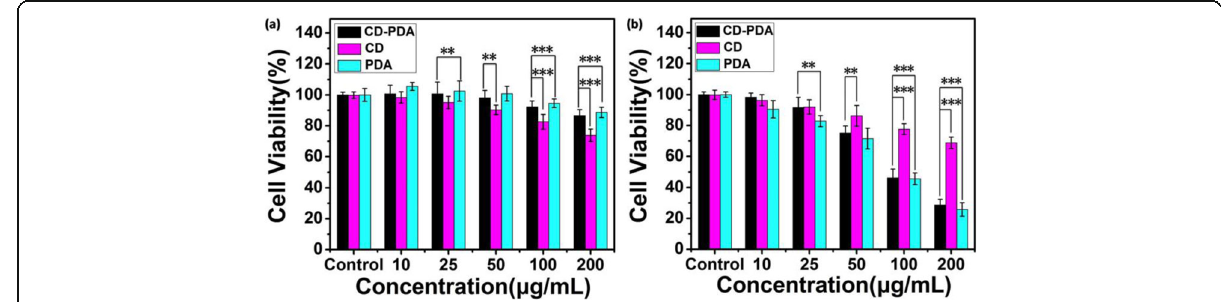
Fig. 5 In vitro cytotoxicity against HeLa cells. a In vitro cell viability of HeLa cells incubated with CD-PDA, CDs, and PDA at various concentrations for 24 h. b In vitro cell viability of HeLa cells incubated with CD-PDA, CDs, and PDA at various concentrations under irradiation (808 nm, 2 W/cm 2 , 5 min; mean ± SD, n = 6). * p < 0.05, ** p < 0.01, *** p <